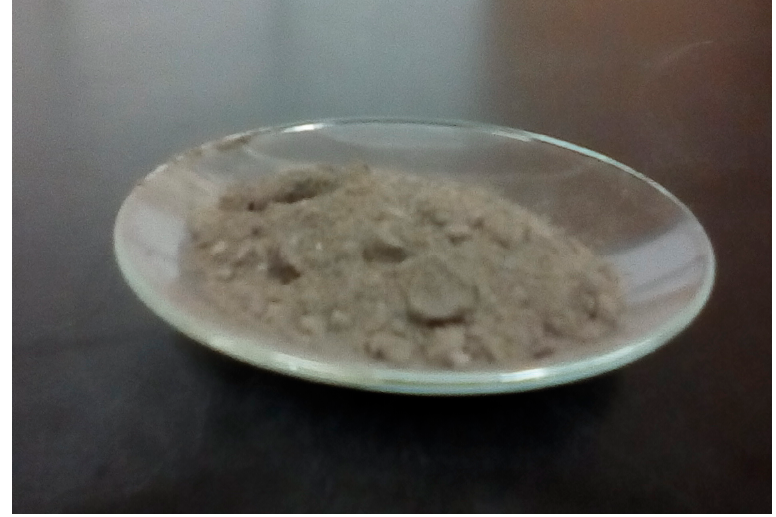
Figure 2. Biosolids-based catalyst as recovered from hydrolysis of biosolid at 280 °C for 1 h. Table 1. Concentration of the main metal species in biosolids-based catalysts as determined by Inductively Coupled Plasma-Optical Emission Spectrometer (ICP-OES).